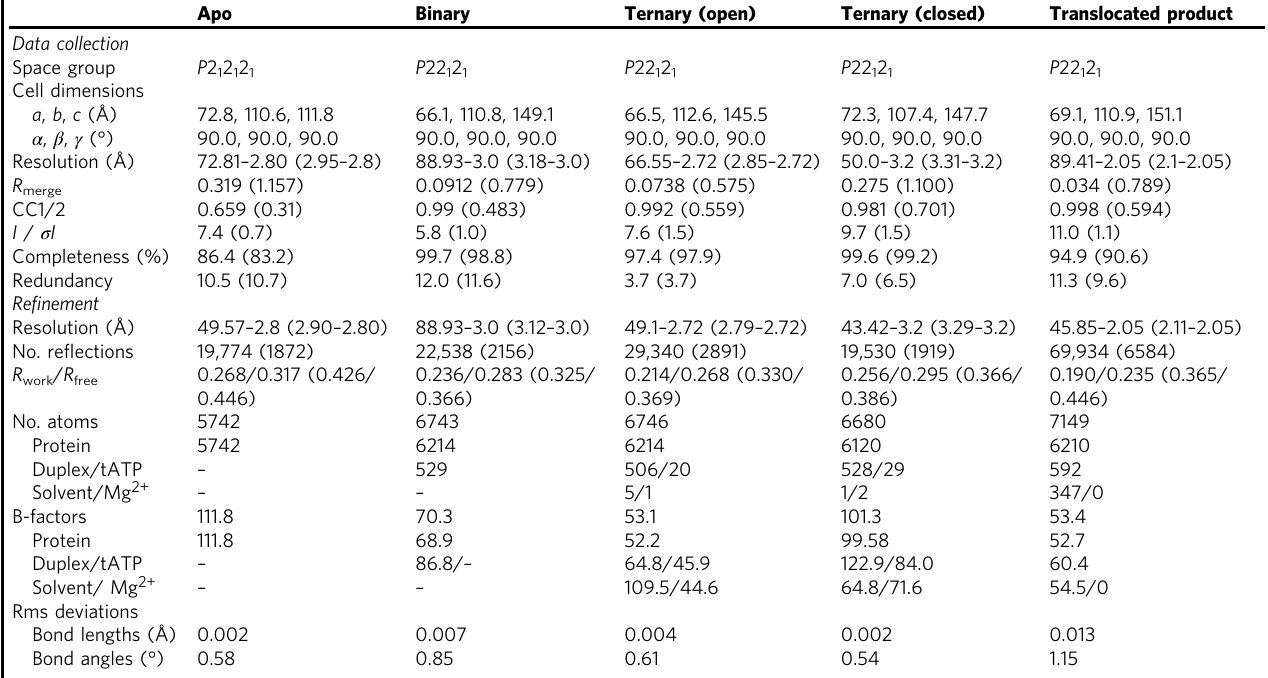
Table 1 Data collection and re fi nement statistics Apo Binary Ternary (open) Ternary